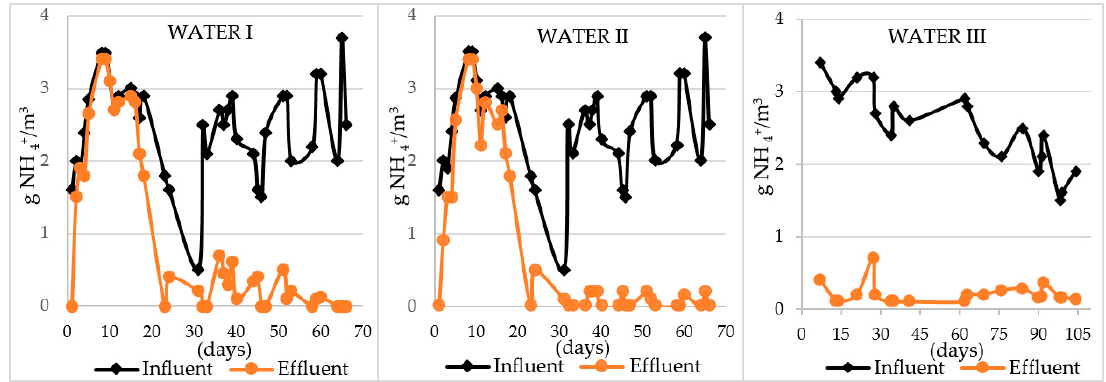
Figure 2. Change in the content of ammonium nitrogen compounds after biofiltration on the chalcedonite bed in the analyzed systems.